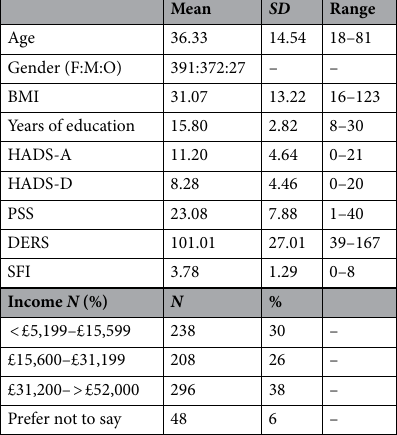
Table 1. Means, standard deviations, and ranges for key participant demographic variables. Gender (F:M:O) = Gender of participants ( N Female: N Male: N Other or Prefer not to say). BMI body mass index, HADS-A, D Hospital Anxiety Depression Scale-Anxiety subscale, Depression subscale, PSS Perceived Stress Scale, DERS Difficulties in Emotion Regulation Scale, SFI Social Frailty